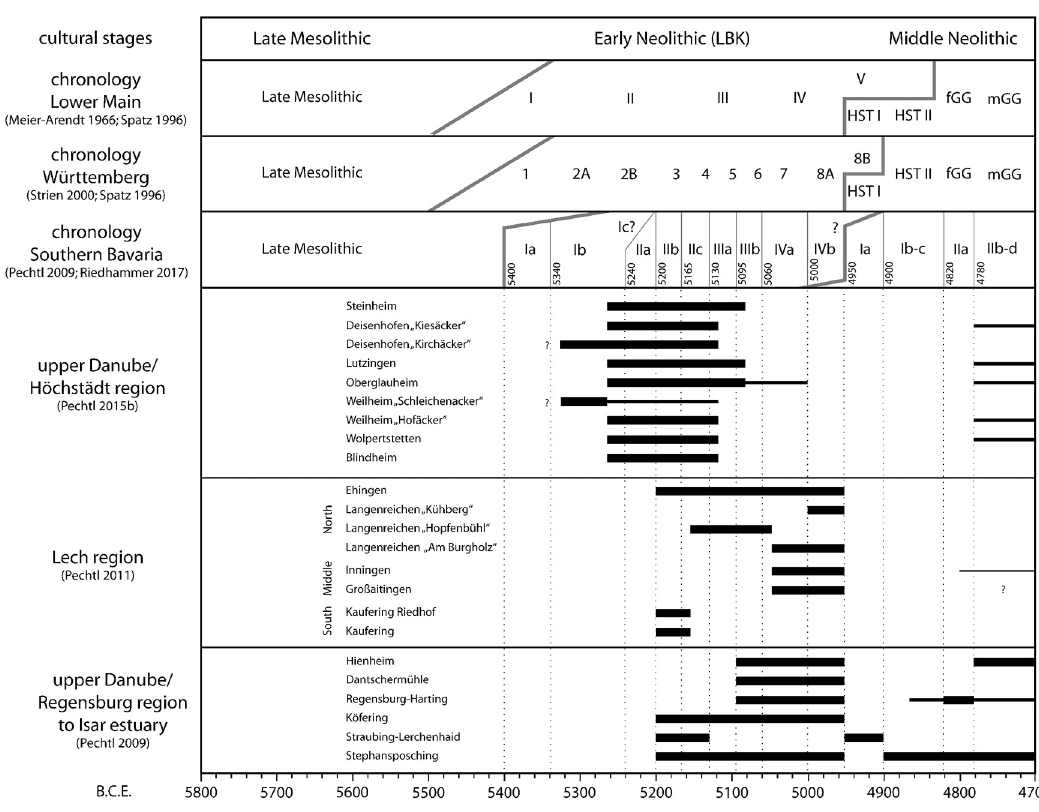
Fig 2. Occupancy of single settlement sites at the upper Bavarian Danube and at the Lech during the LBK and the early Middle